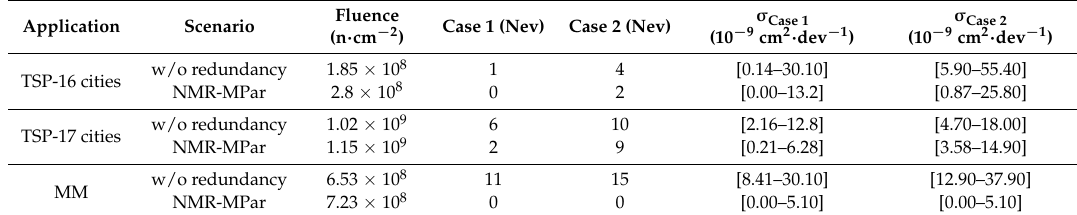
Table 9. Dynamic cross-section for the studied applications.